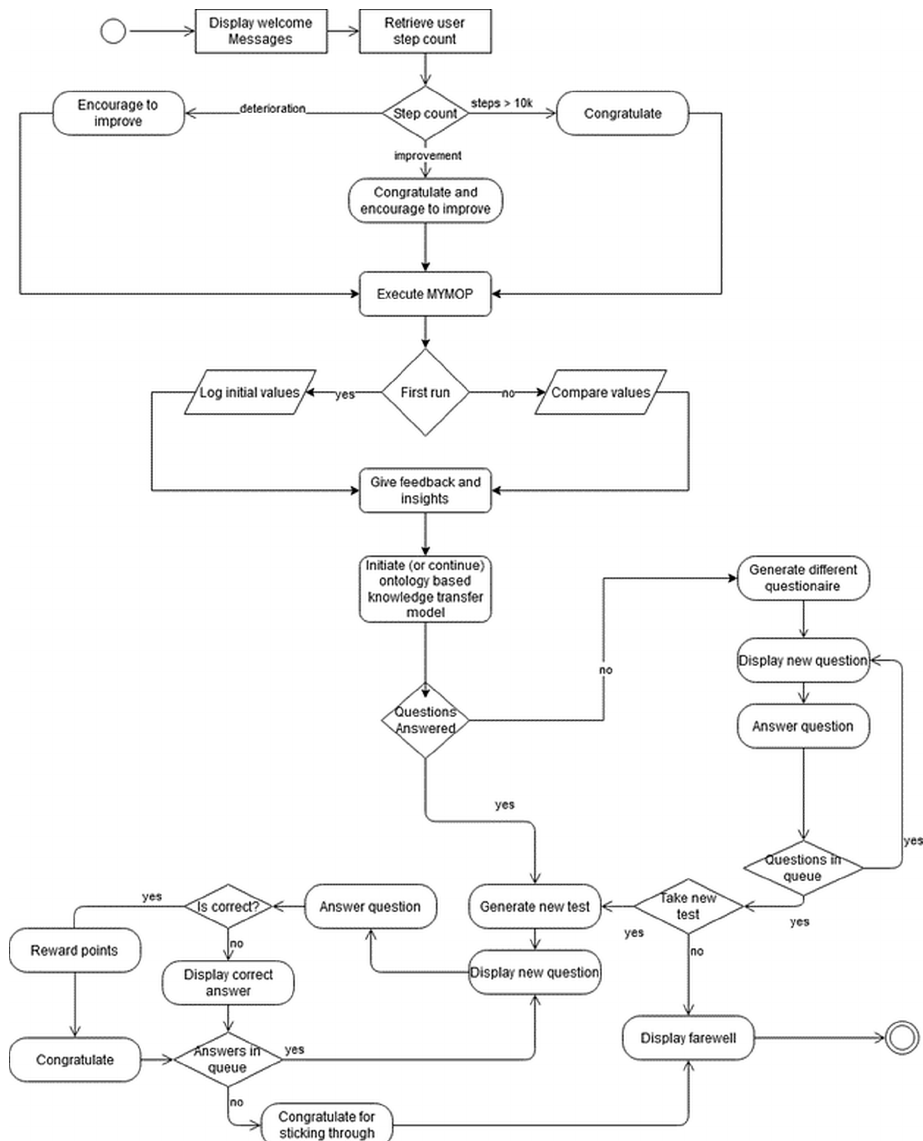
Figure 7. Execution logic of MyRelief serious